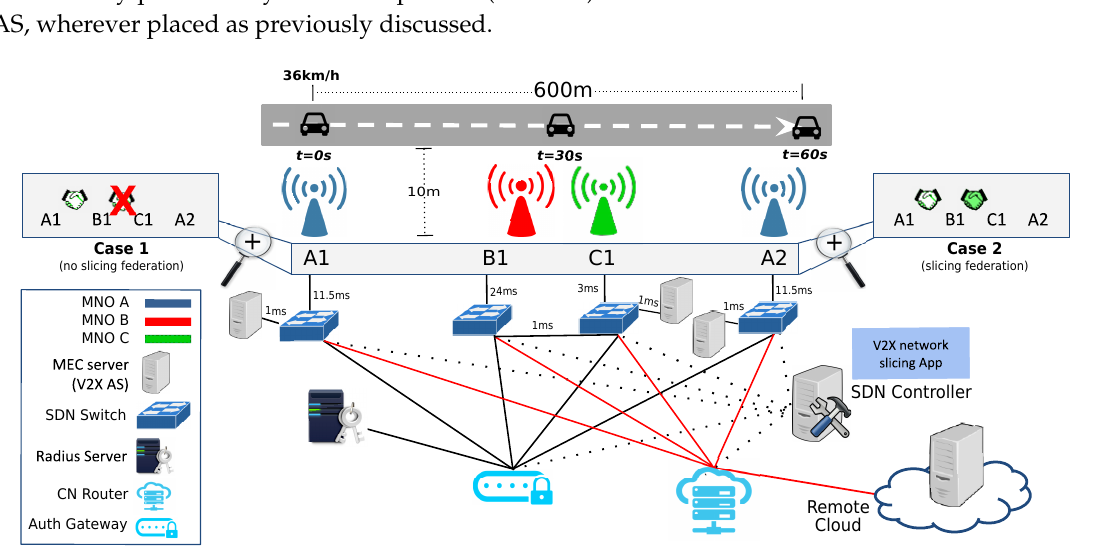
Figure 5. PoC reference scenario of slice capacity aggregation implemented in